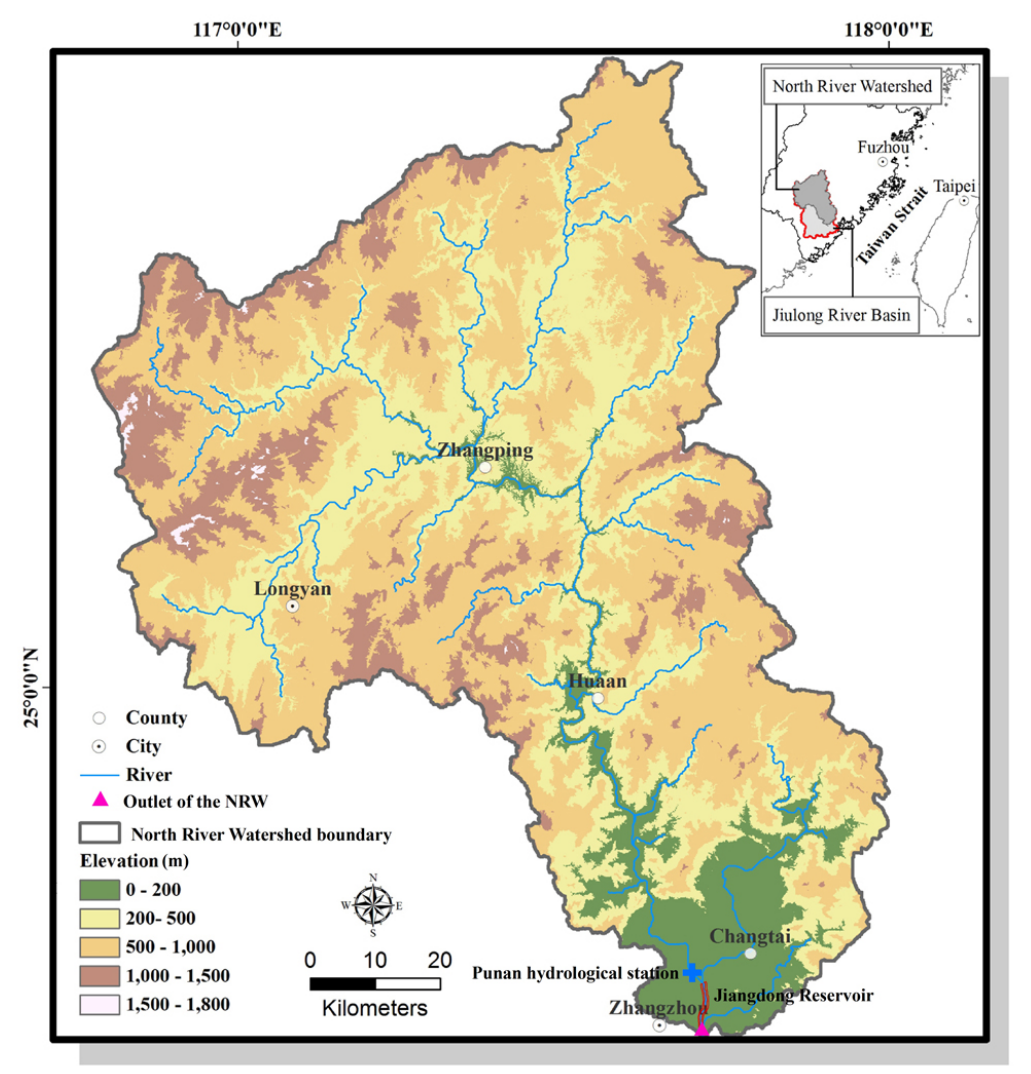
Figure 1. Location of North River